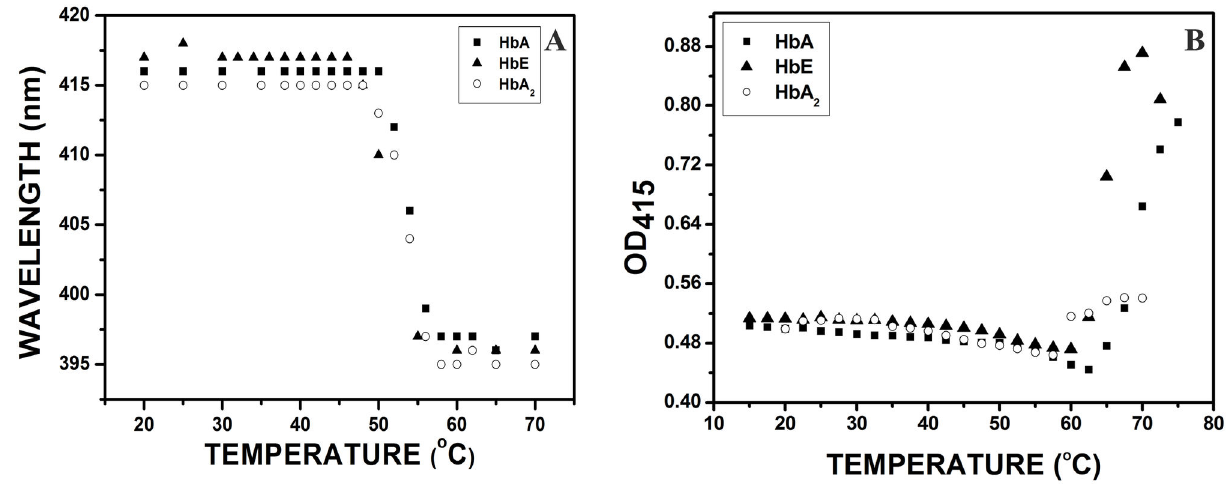
(10.0 µM) at pH 7.0 as recorded from (A) the change in the wavelength Figure 2. Thermal unfolding of HbA, HbE and HbA 2 of Soret absorption maxima (415nm to 395nm) with increasing temperature, where bathochromic shift observed at temperature above 50°C, and (B) the change in absorbance in the Soret region (415nm) measured by uv-visible absorption spectroscopy. The increased intensities beyond 60°C is due to aggregation of globin chains at higher temperature. doi: